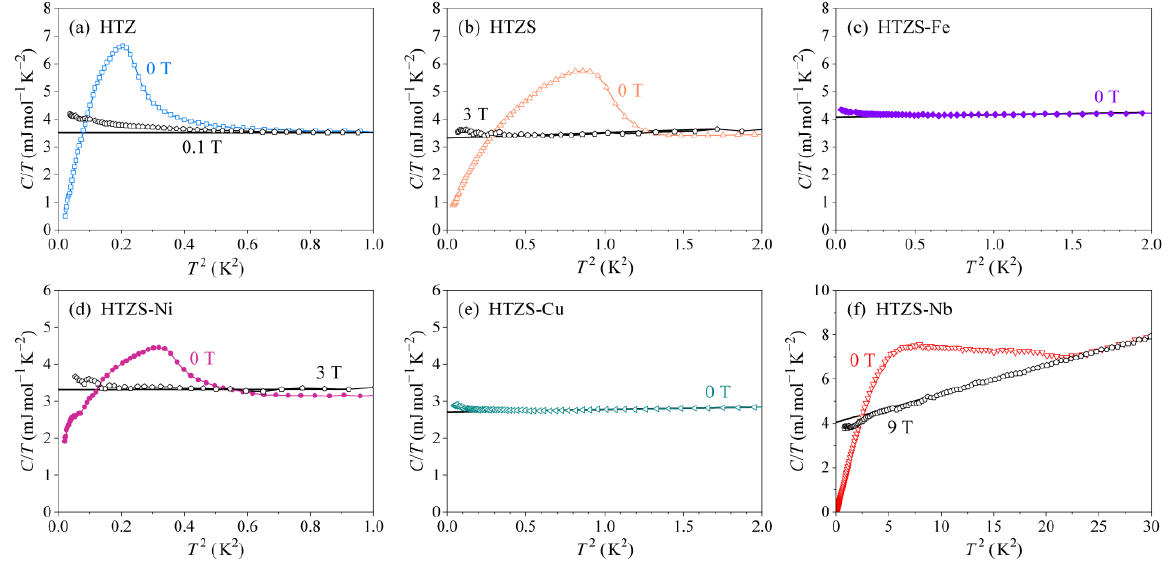
Figure 7. The C / T versus T 2 plots of the zero-field- and the normal-state specific heat (the latter was measured for the SC samples in a field H > H c 2 ) of the samples ( a ) HfTiZr (HTZ), ( b ) HfTiZrSn (HTZS), ( c ) HfTiZrSnFe (HTZS-Fe), ( d ) HfTiZrSnNi (HTZS-Ni), ( e ) HfTiZrSnCu (HTZS-Cu), ( f ) HfTiZrSnNb (HTZS-Nb). Solid lines are C / T = γ + α T 2 fits of the normal-state specific heat.